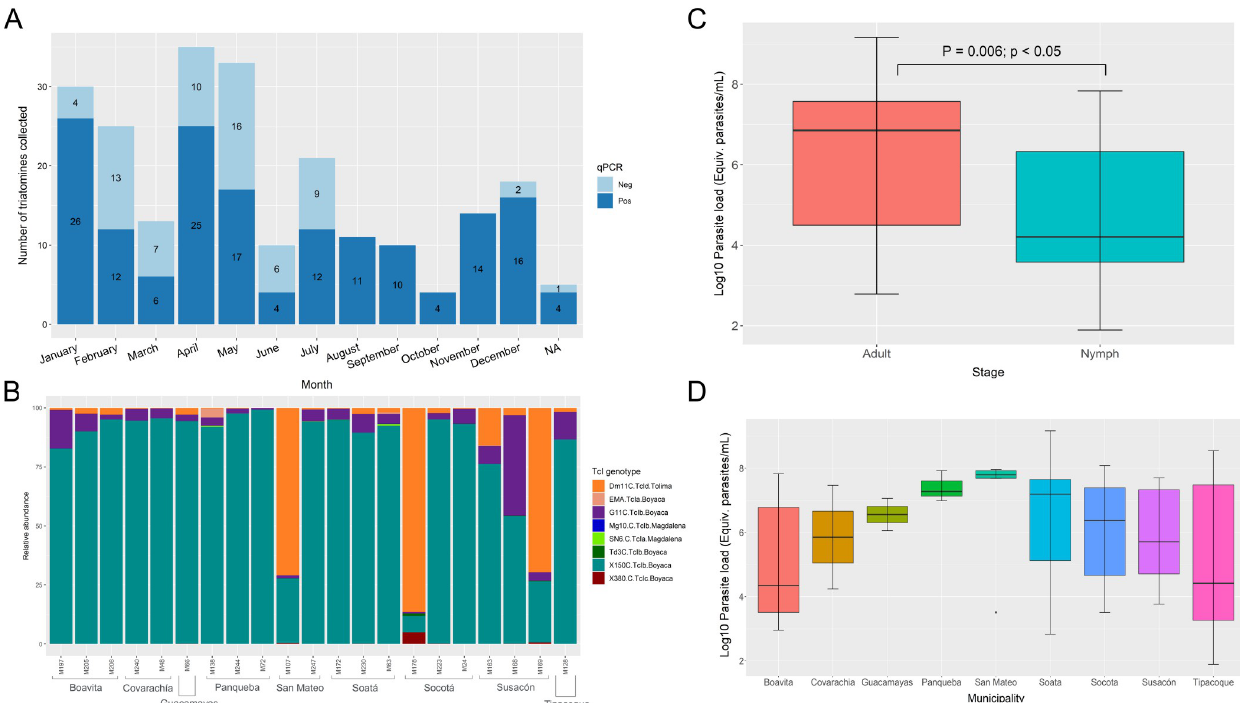
Fig 3. T . cruzi infection, DTUs, and parasite loads of T . dimidiata specimens collected. A) Number of triatomines collected per month and infection qPCR results (positive or negative), B) Relative abundance of TcI genotypes per sample and municipality where each sample was collected, C) Parasite loads values per developmental stage (p-value of 0.006; p < 0.05) and D) Parasite loads per municipality (p-value: 0.048; p < 0.05). Boxplots parasite load values on Y axis were transformed to Log10 scale to enhance the data visualization considering the outlier loads we